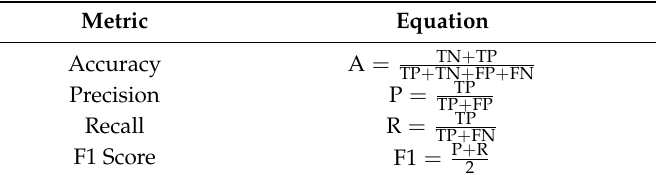
Figure 4. Confusion matrix. Table 4. Classification metrics.